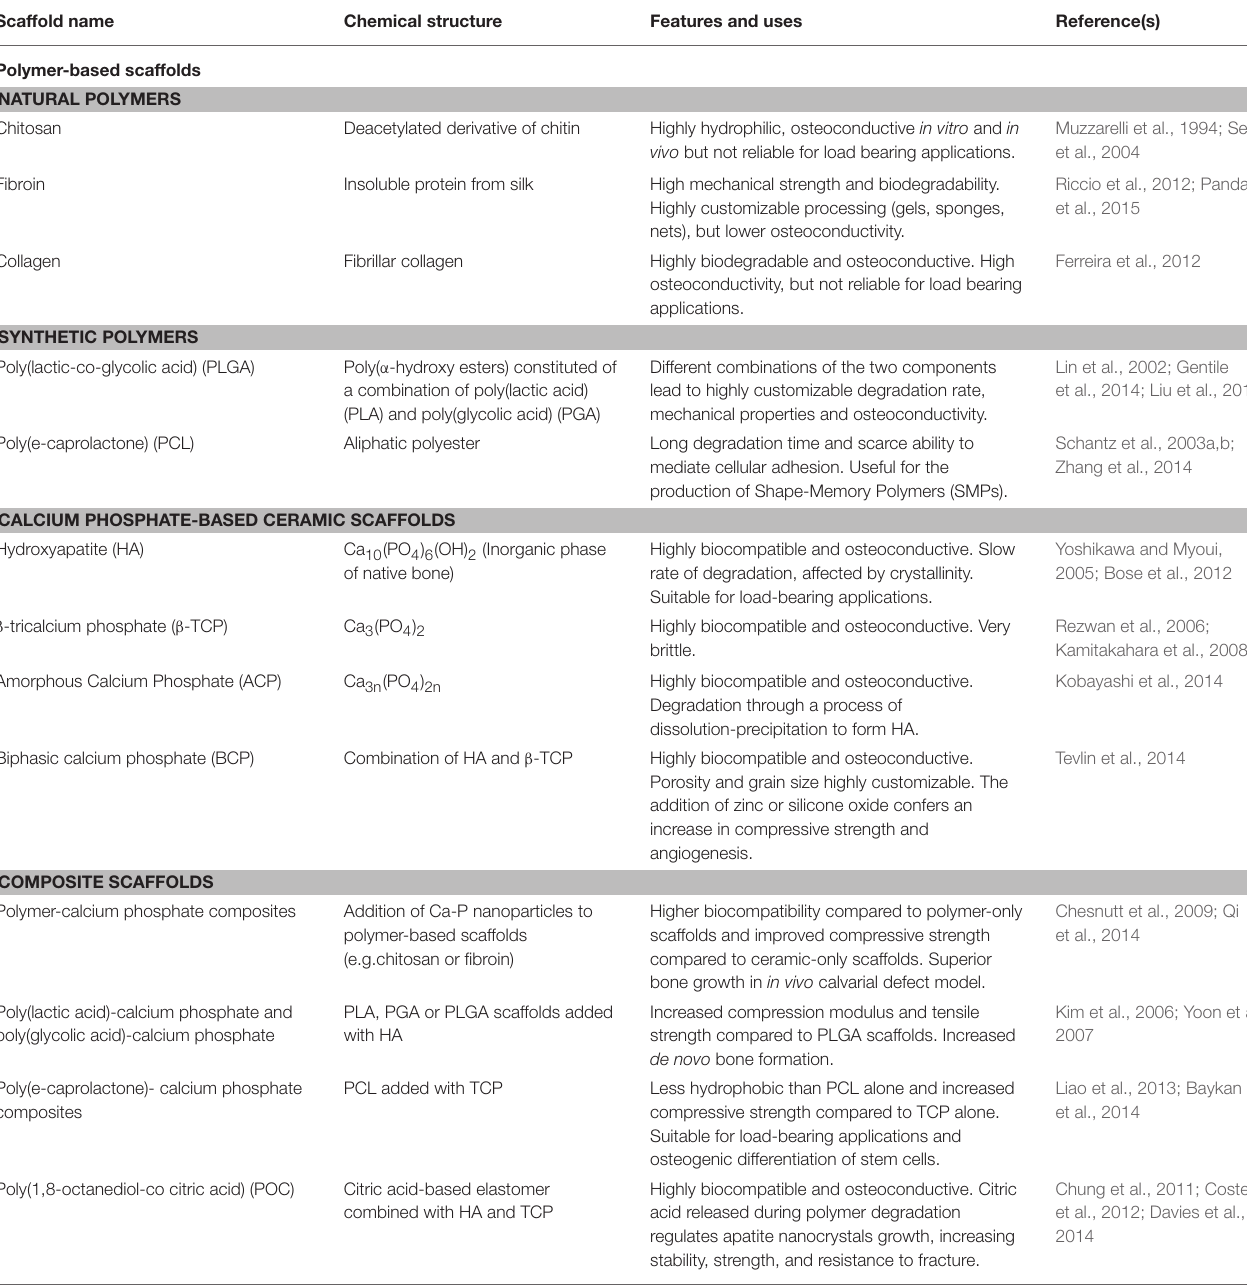
TABLE 1 | Most used biomimetic scaffolds for cranio-facial bone regeneration in cell-based and cell-free